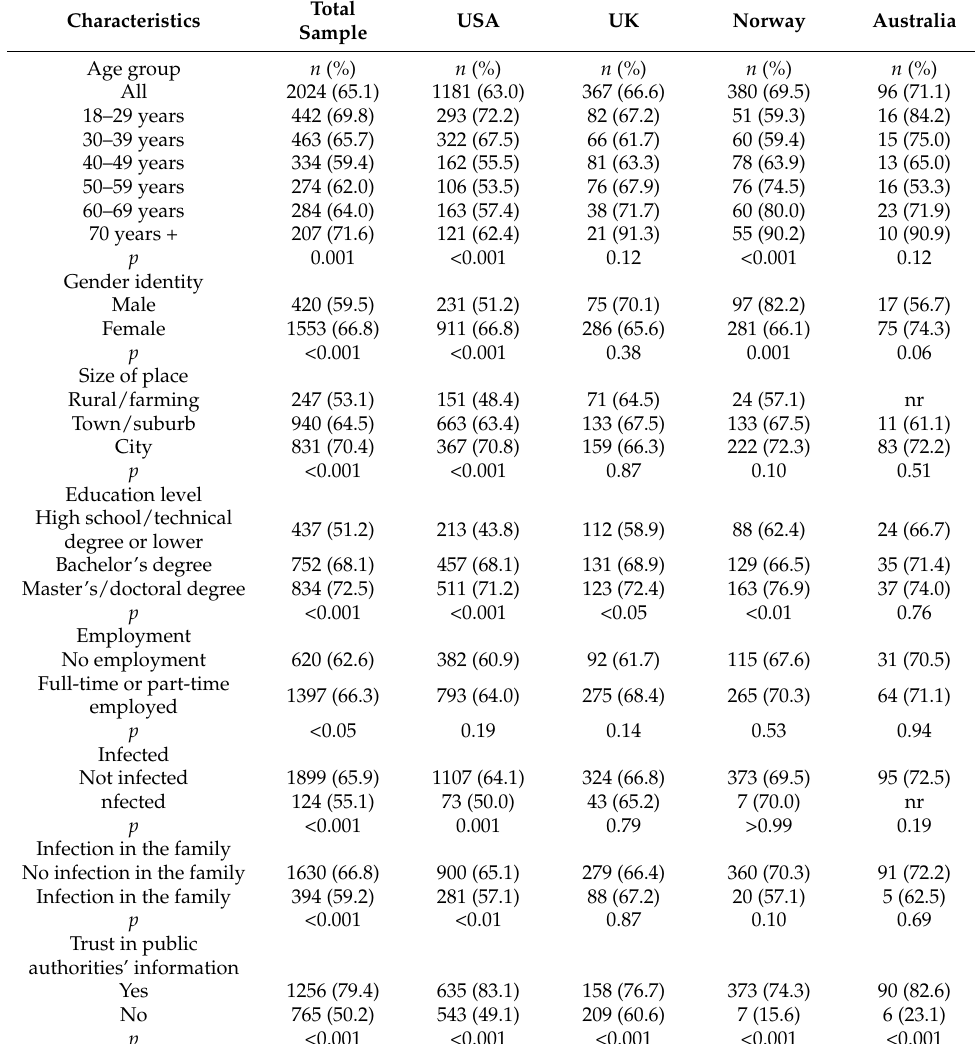
Table 1. Number and proportions of participants likely or very likely to take the COVID-19